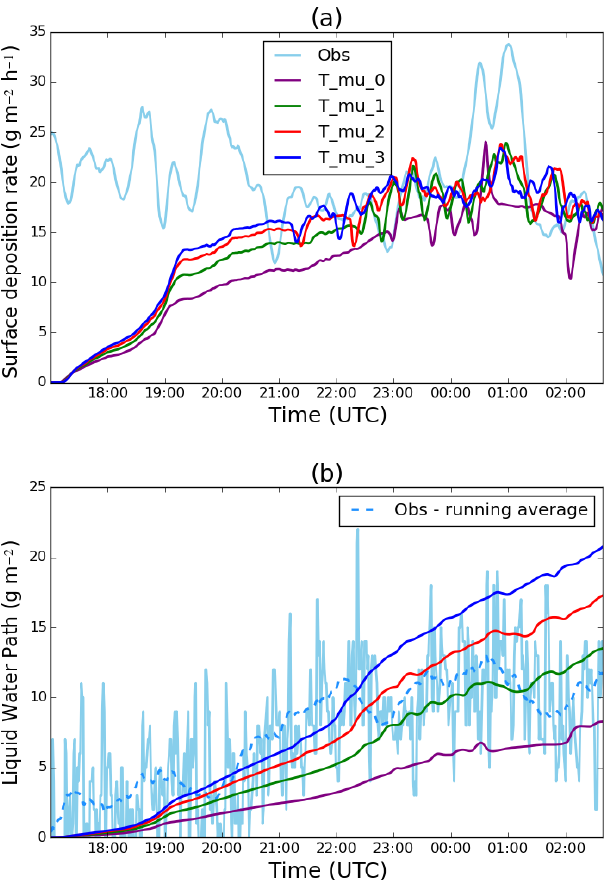
Figure B1. (a) Time series of the surface deposition rate (gm − 2 h − 1 ). Purple – T_mu_0; green – T_mu_0; red – T_mu_1; dark blue – T_mu_3; light blue – observations. (b) Time series of the liquid water path (gm − 2 ). Purple – T_control; green – T_mu_1; red – T_mu_2; dark blue – T_mu_3; light blue – observations; blue dashed line – running average over observations (40